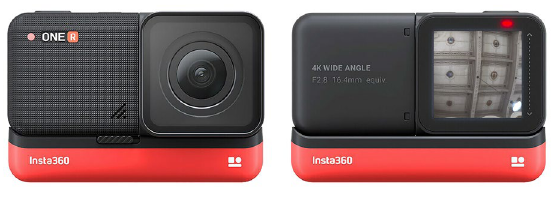
Figure 1 . Front and back of the modular Insta360 ONE R with a wide-angle